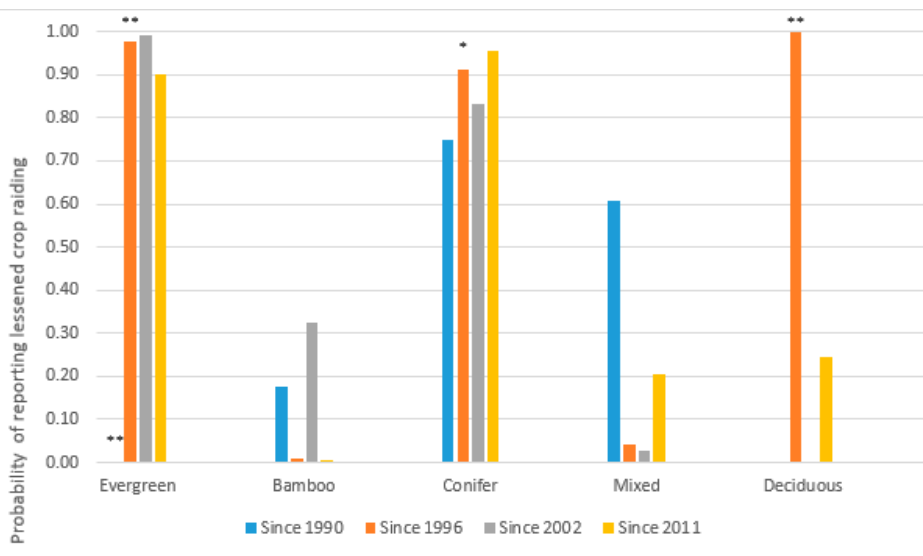
Figure 8. Probability of reporting crop raiding having lessened in the past 10 years if estimated boar density decreased by 0.001 BPD between the given year and 2015 (* p < 0.05; ** p < 0.01). Table 4. Log-odds of reporting crop raiding as “serious” or “very serious” in the 2015 survey based on interpolated boar density (“In 2015”); log-odds of reporting crop raiding as becoming less severe in the past 10 years based on estimated changes in boar density between a given year and 2016 (“Since [year]”).